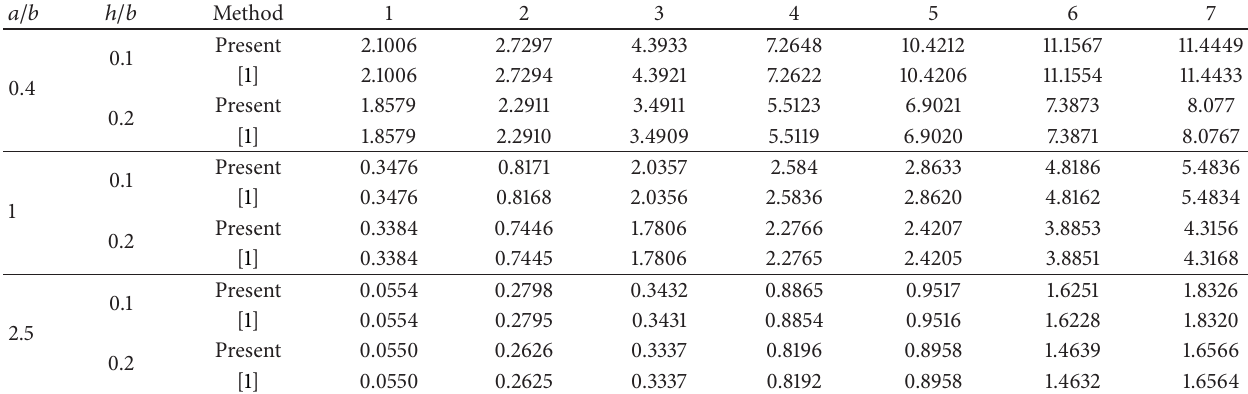
Table 3: The first seven frequency parameters Ω = ( 𝜔𝑏 2 / 𝜋 2 )( 𝜌ℎ/𝐷 ) 1/2 for C-F-F-F Mindlin rectangular plates.